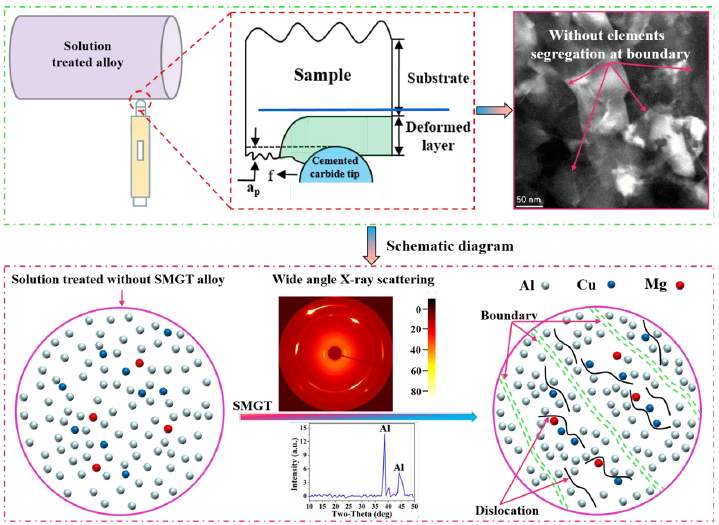
Figure 10. Schematic diagram of the elements’ segregation at the boundary, observed rarely during the SMGT